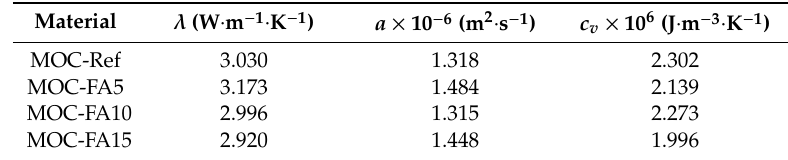
Table 8. Thermal parameters of developed